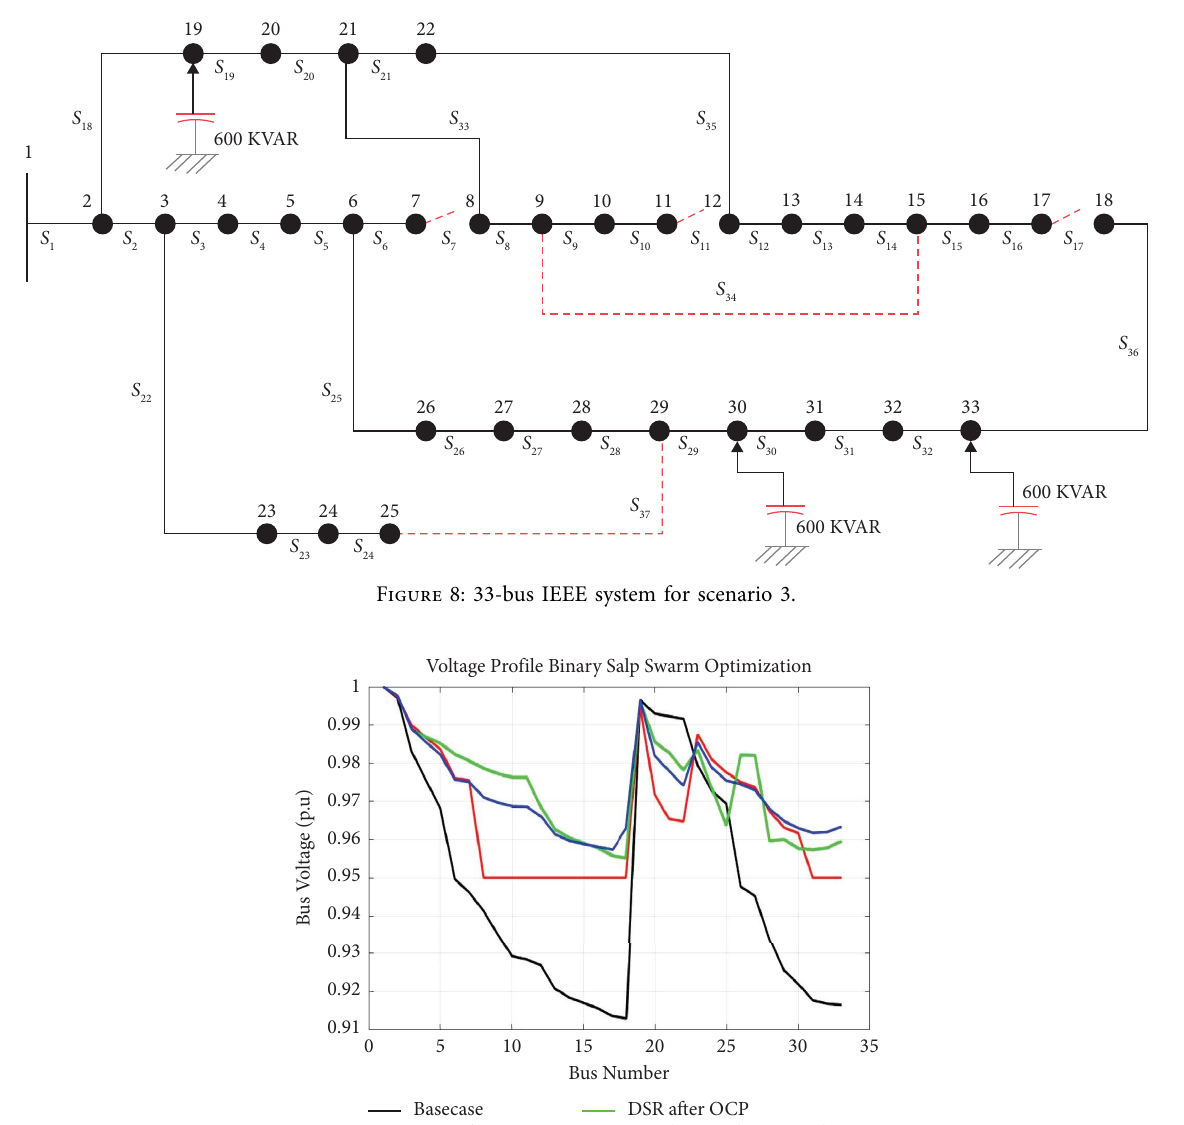
Figure 9: Voltage profle for 33-bus using BSSA algorithm for three scenarios with the base